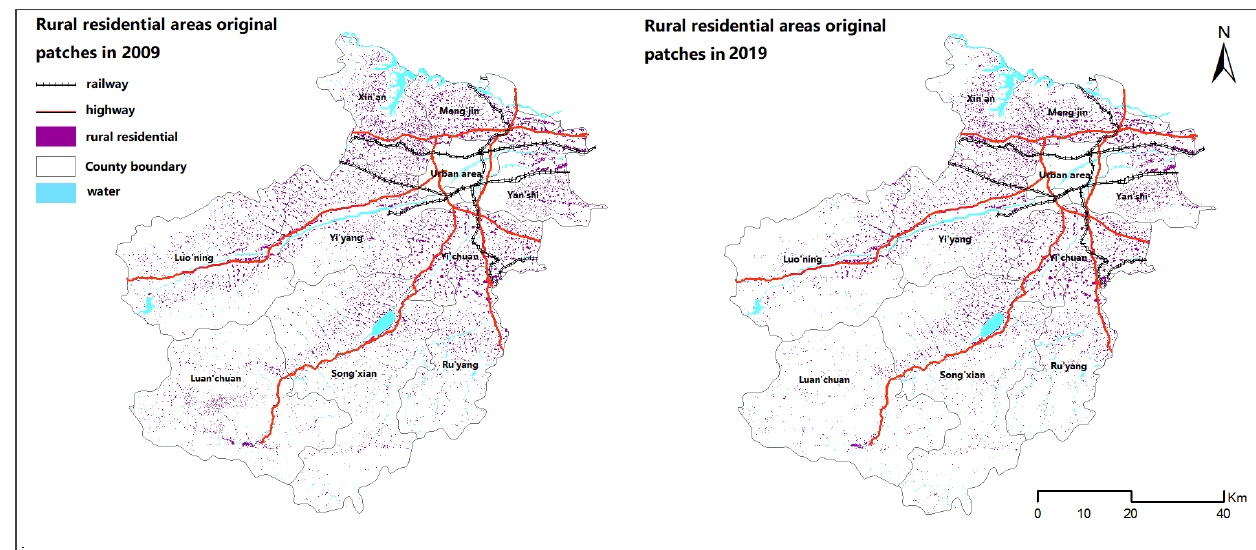
Figure 2. Rural residential areas — original patches in Luoyang region.